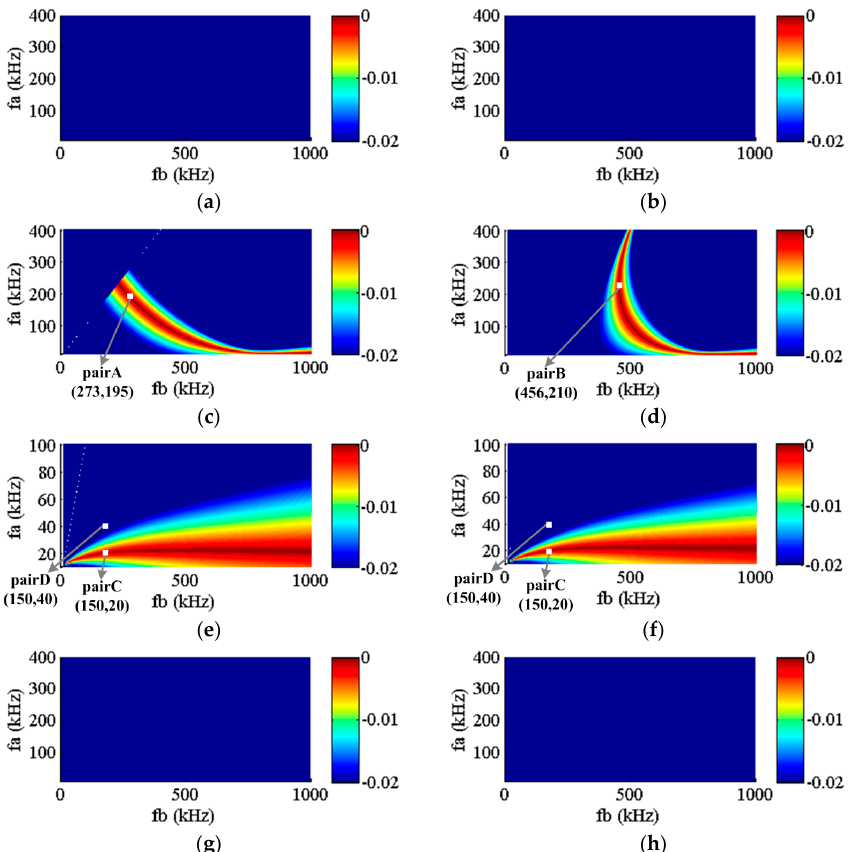
Figure 3. The modulation plots of A0A0 − S0, S0S0 − S0, S0A0 − A0, A0S0 − A0: ( a ) k d+ of A0A0 − S0; ( b ) k d- of A0A0 − S0; ( c ) k d+ of S0S0 − S0; ( d ) k d- of S0S0 − S0; ( e ) k d+ of S0A0 − A0; ( f ) k d- of S0A0 − A0; ( g ) k d+ of A0S0 − A0; ( h ) k d- of A0S0 − A0.